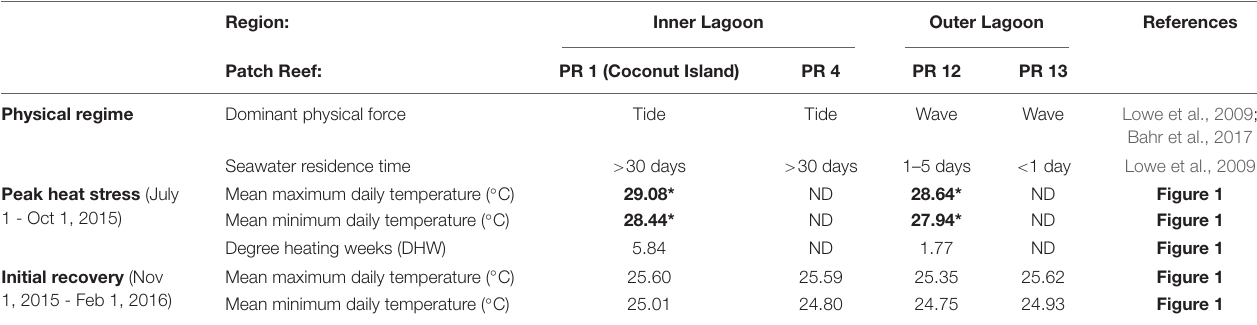
Bold numbers with asterisks indicate statistical significance (p < 0.03; Wilcoxon rank sum test).